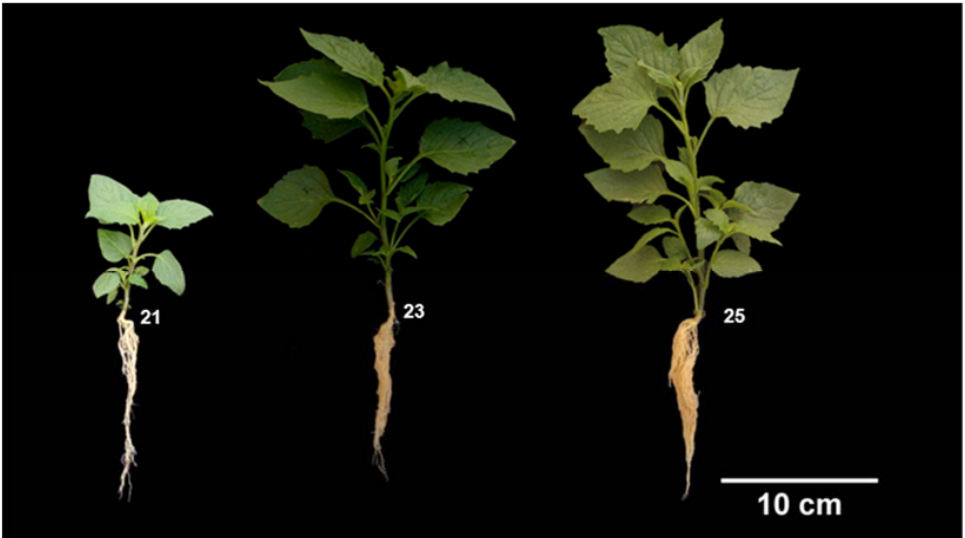
Figure 7. Principal stage 2 (formation of side shoots) of slender nightshade plants ( Solanum nigrescens ) based on the BBCH scale: 21: first primary apical side shoot visible; 23: third primary apical side shoot visible; 25: fifth primary apical side shoot visible. Photos by Sara Monzerrat Ramírez-Olvera.